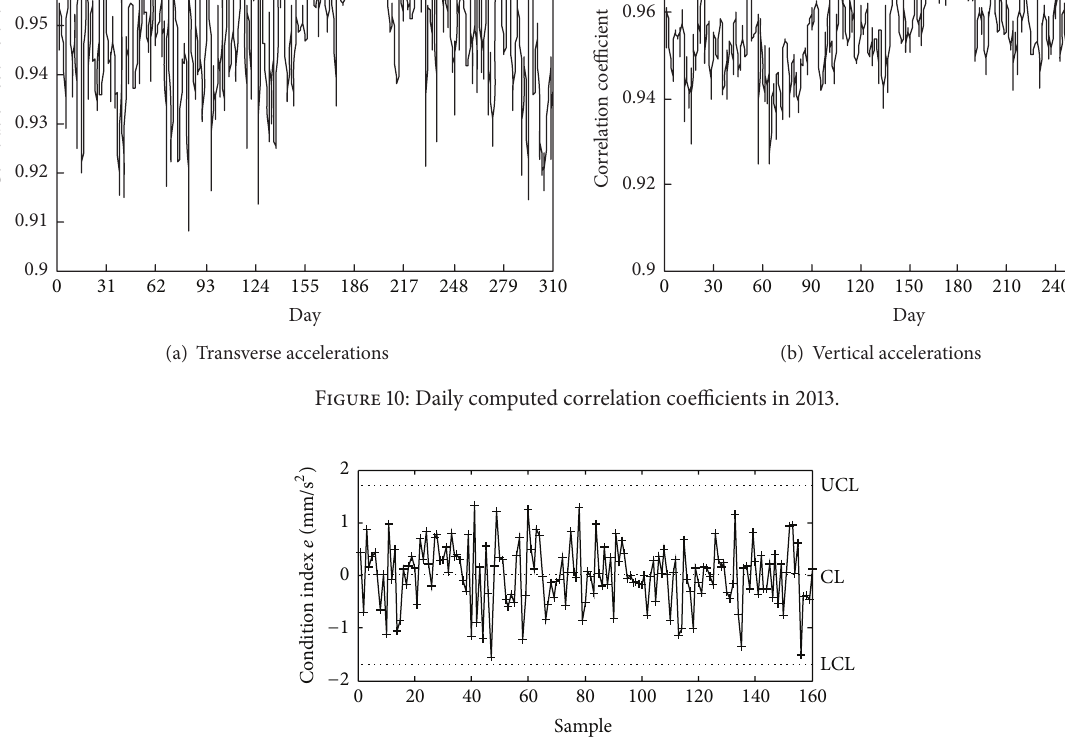
Figure 11: Mean value control chart for accelerations in the middle of the second